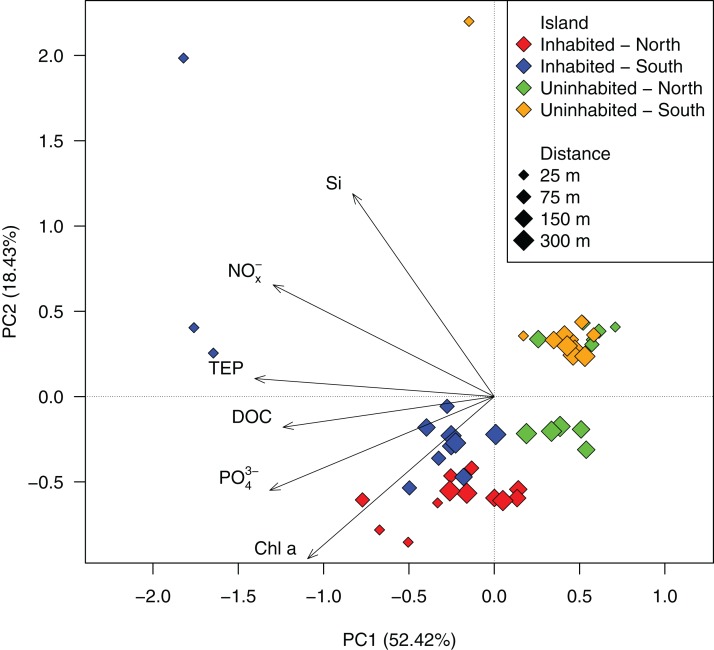
PCA ordination of the measured water quality parameters at the inhabited and uninhabited island.PC1 and PC2 explained 52.42% and 18.43% of the total variation, respectively. NOx−, nitrite/nitrate; PO43−, phosphate; Si, silicate; Chl a, chlorophyll a; DOC, dissolved organic carbon; TEP, transparent exopolymer particles.